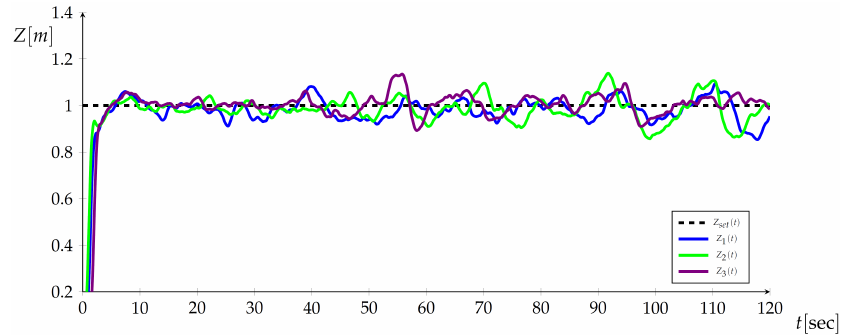
Figure 10. Tracking of the reference altitude Z set by the Bebop 2 UAV in three trials ( Z 1 – Z 3